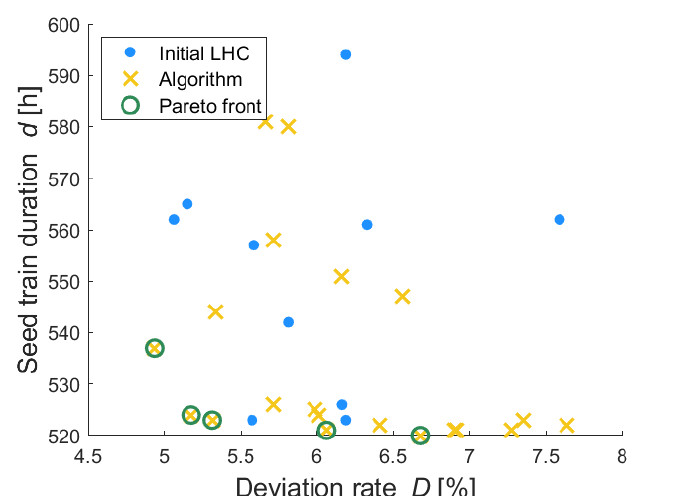
Figure 3. Algorthmically determined solutions and Pareto front of the two objective criteria seed train duration and deviation rate. (optimizable variables, here combinations of 5 shake flask filling volumes). Blue dots show an initial Latin hypercube design (LHC); yellow crosses are the points proposed by the algorithm; green circles are Pareto optimal solutions (=Pareto front).